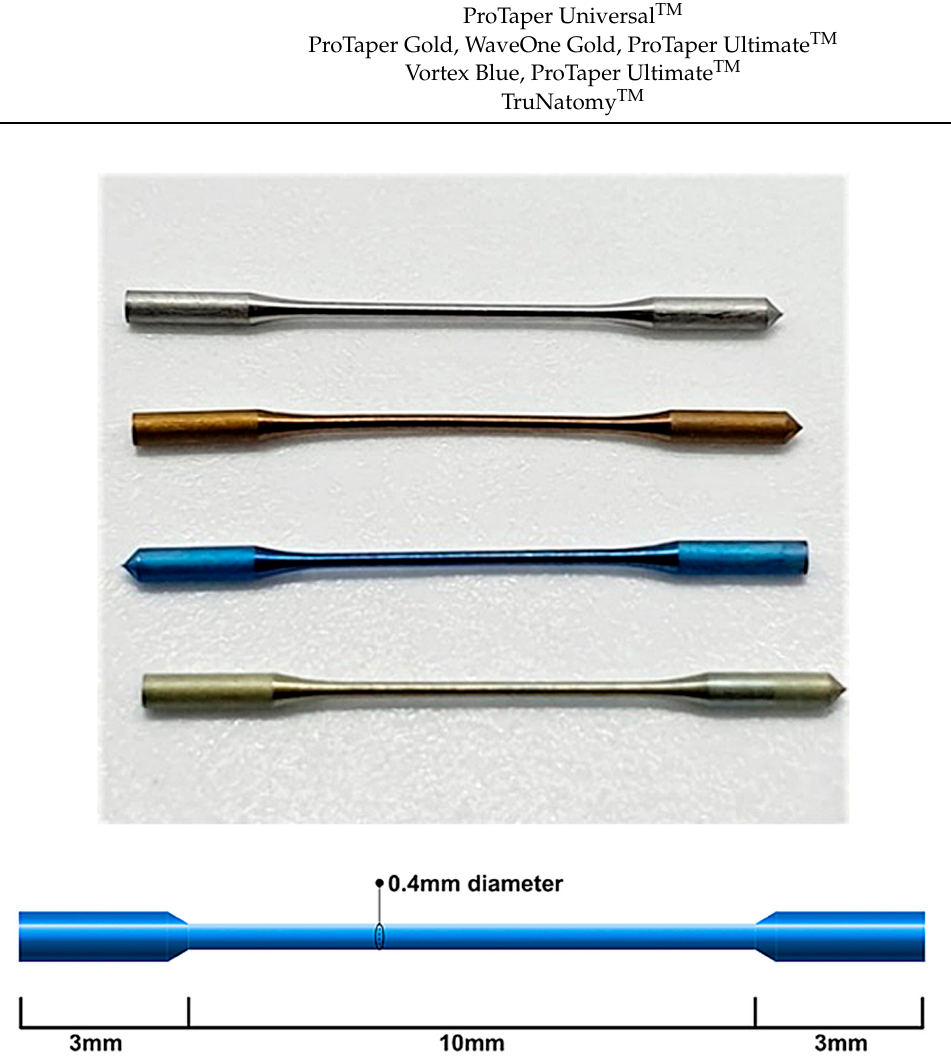
Figure 3. Wire blank specimens purpose-made for the fabrication of Dentsply endodontic instruments. Top: Photograph of Stock, Gold, Blue and Superflex wire blanks. Bottom: Schematic diagram showing the dimensions of each wire blank.